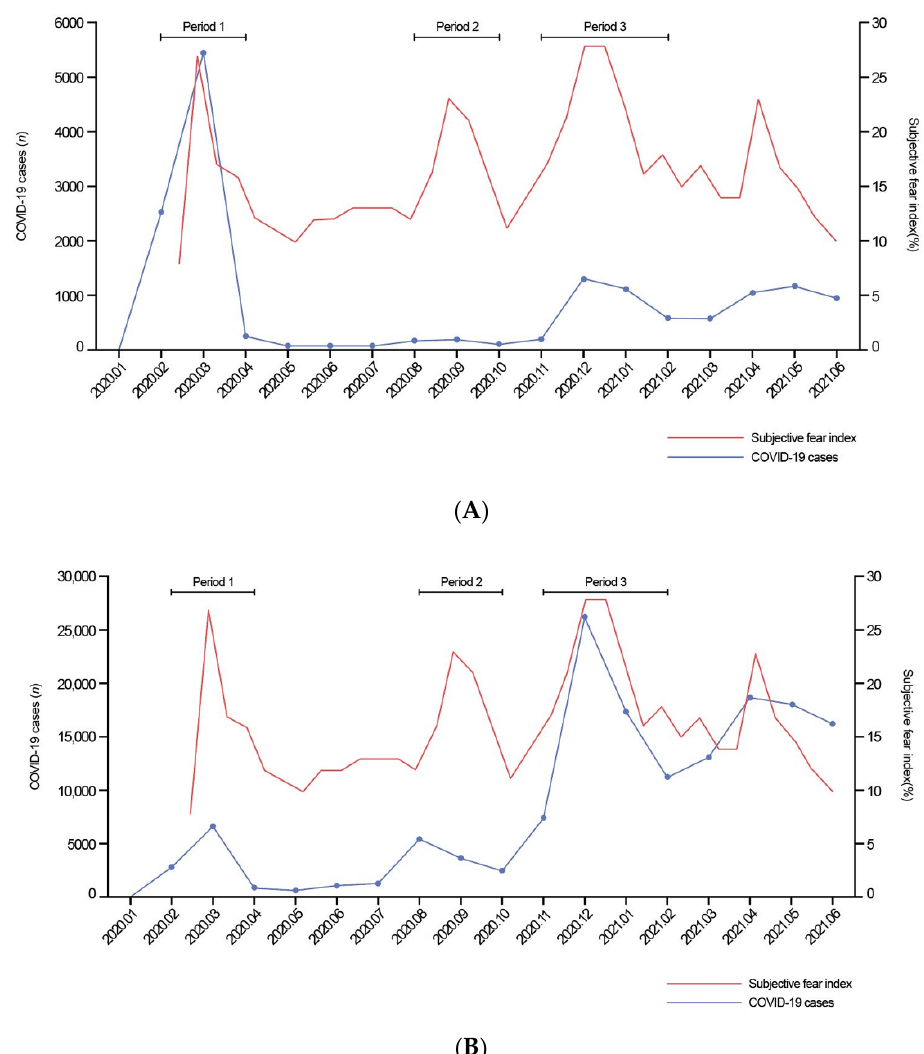
Figure 1. Definition of coronavirus disease (COVID-19) pandemic periods according to the ( A ) regional and ( B ) nationwide outbreaks.